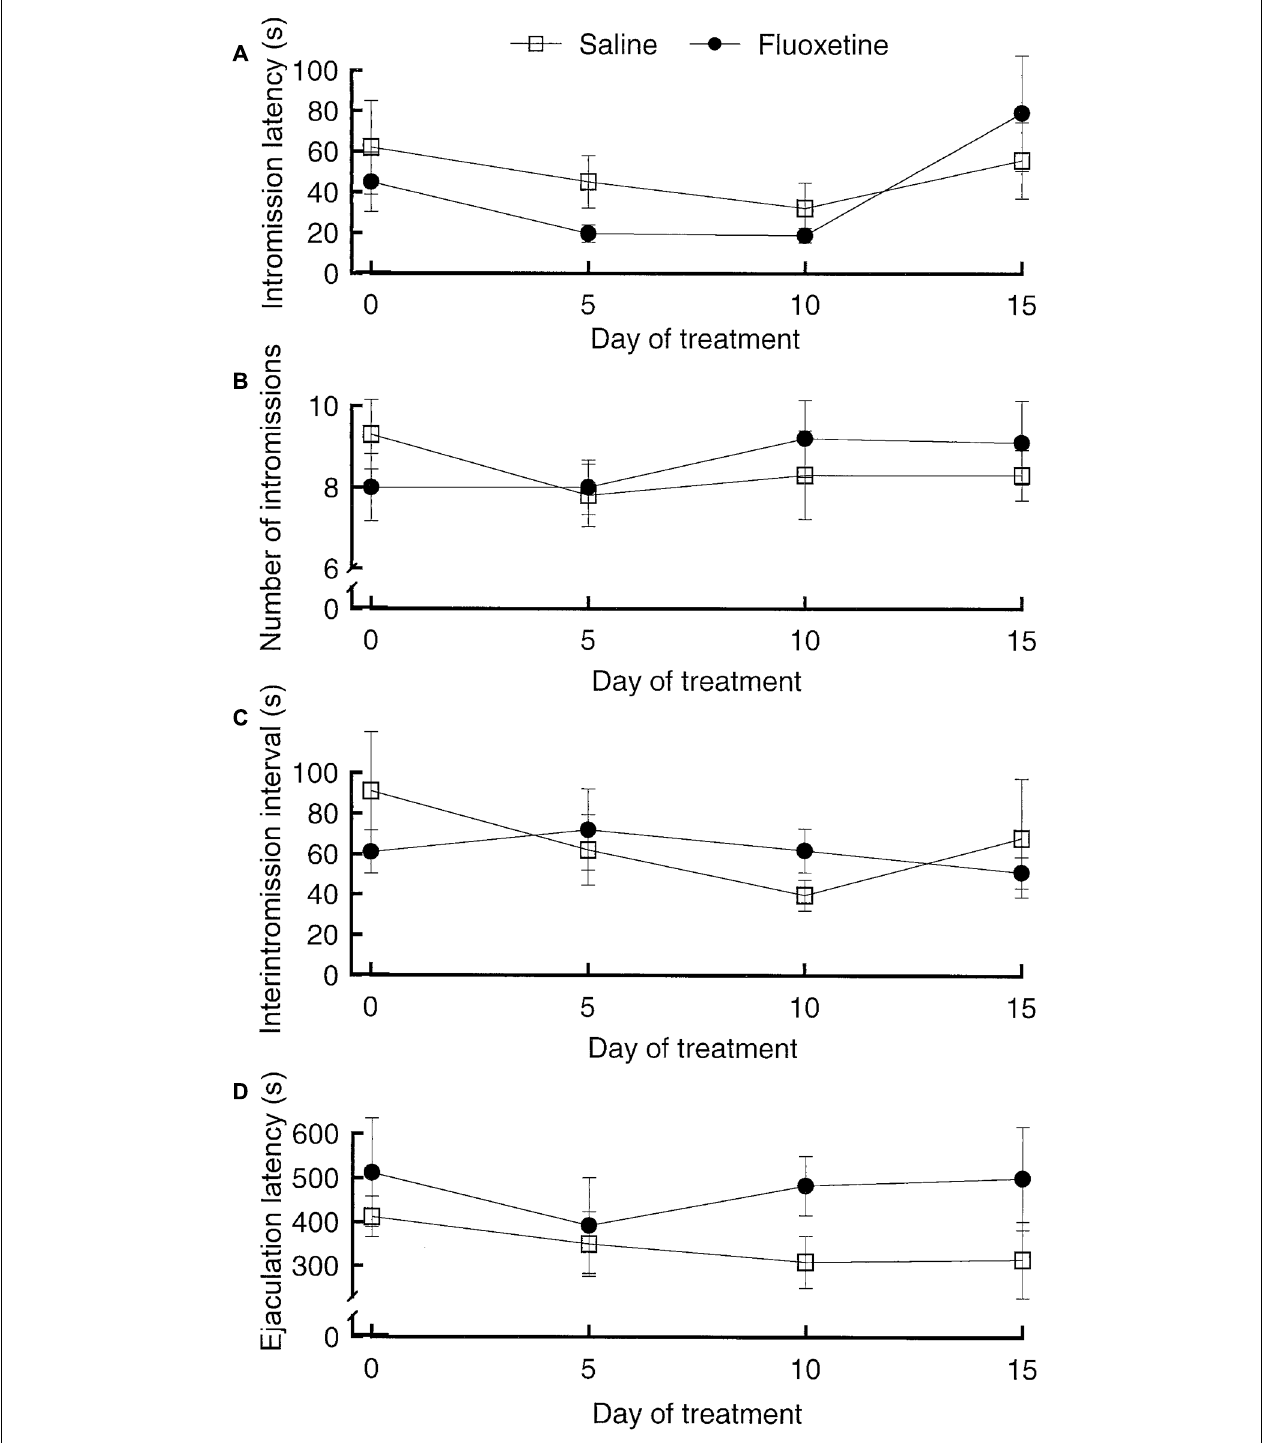
FIGURE 5 | Parameters of copulatory behavior in male rats treated with fluoxetine, 10 mg/kg per day orally, or saline for 15 days. The test on Day 0 was performed 1 h after the first fluoxetine administration. (A) Intromission latency. Analysis of variance (ANOVA) for repeated measures on the factor Day of treatment and independent measures on the factor Treatment failed to reveal any statistically significant effect of Treatment, of Day of treatment and of the interaction Day × treatment (all p s > 0.07). (B) Number of intromissions. Also here, ANOVA failed to detect any significant effect (all p s > 0.51). (C) Interintromission interval. No effect (all p s > 0.39). (D) Ejaculation latency. No effect (all p s > 0.13). Data are mean ± standard error of the mean (SEM). Data are from an unpublished experiment, performed by one of the present authors (AÅ) together with Juoni Sirviö, Gro Sandberg and Live Sørensen.